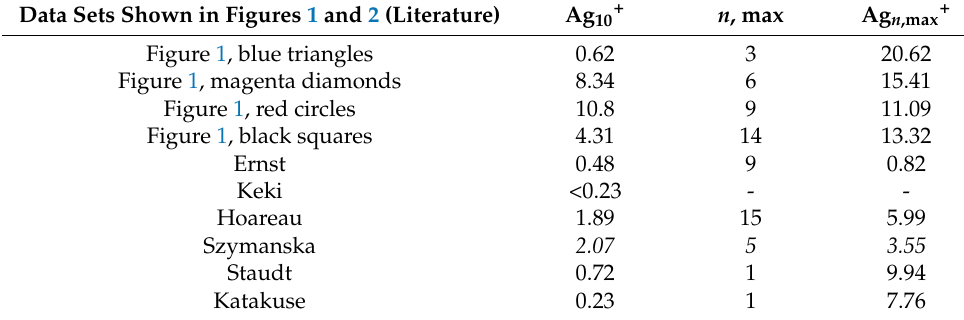
Table 1. Relative amount (in %) of silver in Ag 10+ and the most abundant silver cluster ion formed in the experiments shown in Figures 1 and 2. Italic fonts indicate that these values are upper limits since some mass peaks were off-scale in the respective studies.